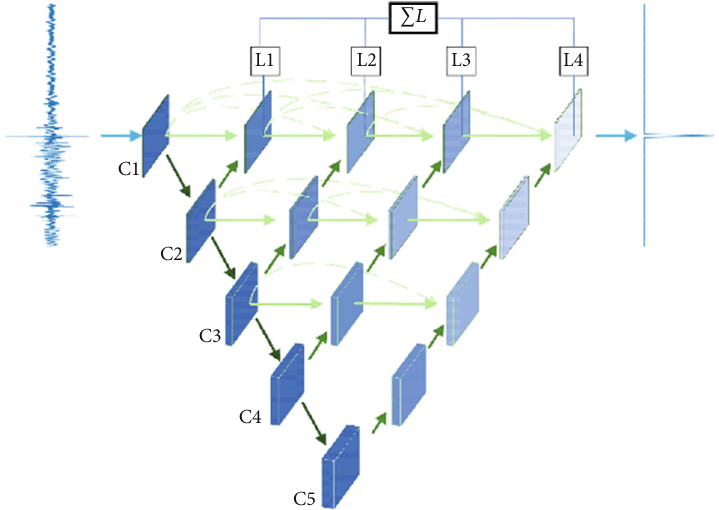
Figure 1: UNet++ model